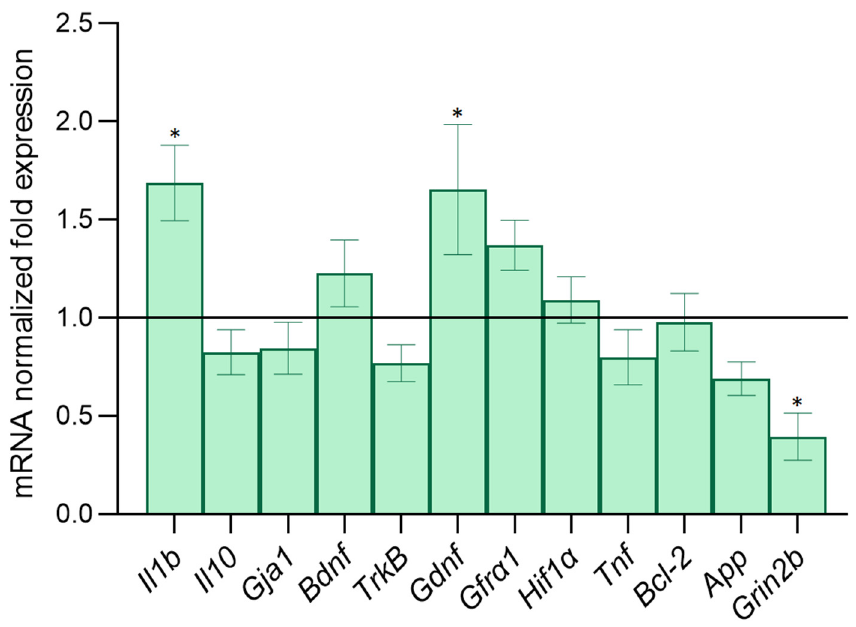
Figure 10. Level of mRNA expression of genes of interest in astrocytic cultures during chronic application of β -amyloid. Data are normalized relative to intact cultures. *—statistically significant difference between experimental groups, p ≤ 0.05 (one-way ANOVA and Tukey’s multiple post-hoc test).